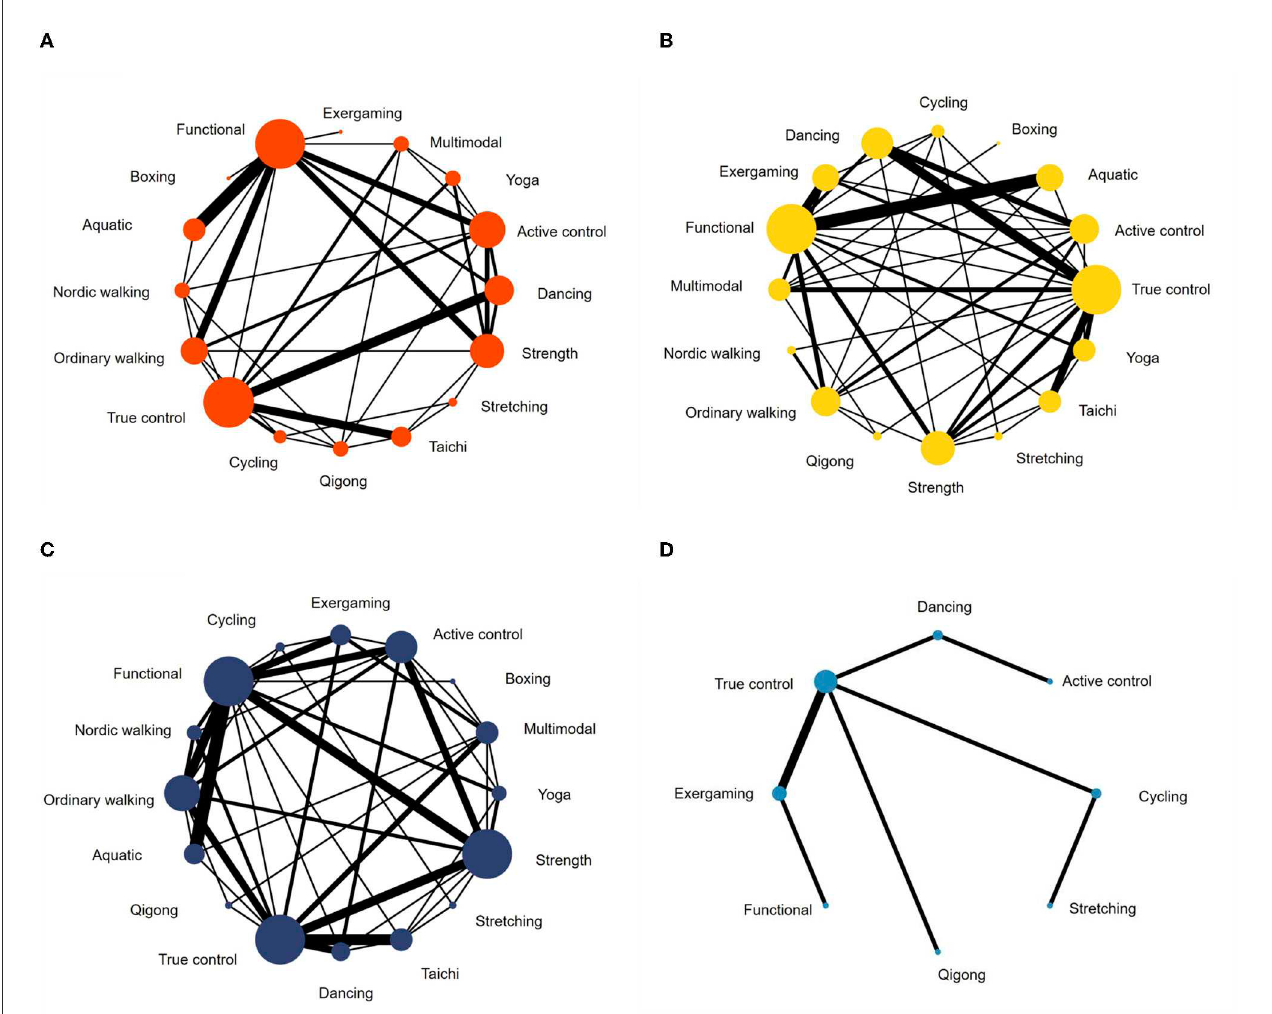
FIGURE3 Network meta-analysis maps of studies examining the efficacy of exercise interventions in patients with Parkinson’s disease on (A) UPDRS-motor scale, (B) balance, (C) mobility, and (D) manual dexterity.